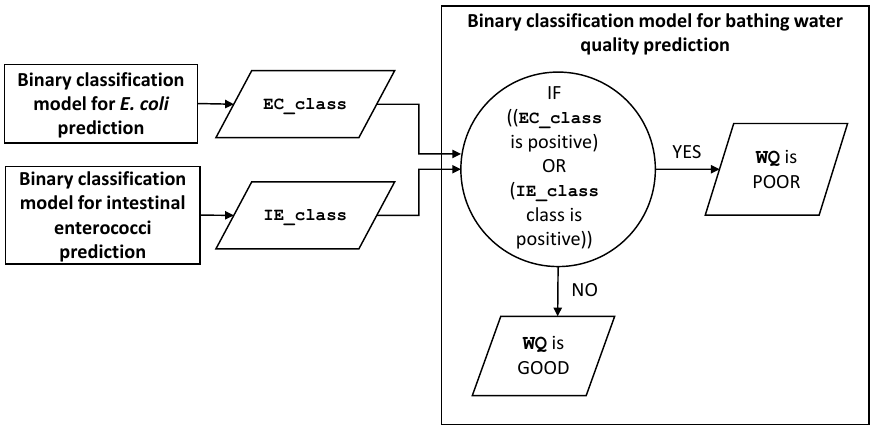
Figure 2. Scheme of the binary classification model for bathing water quality